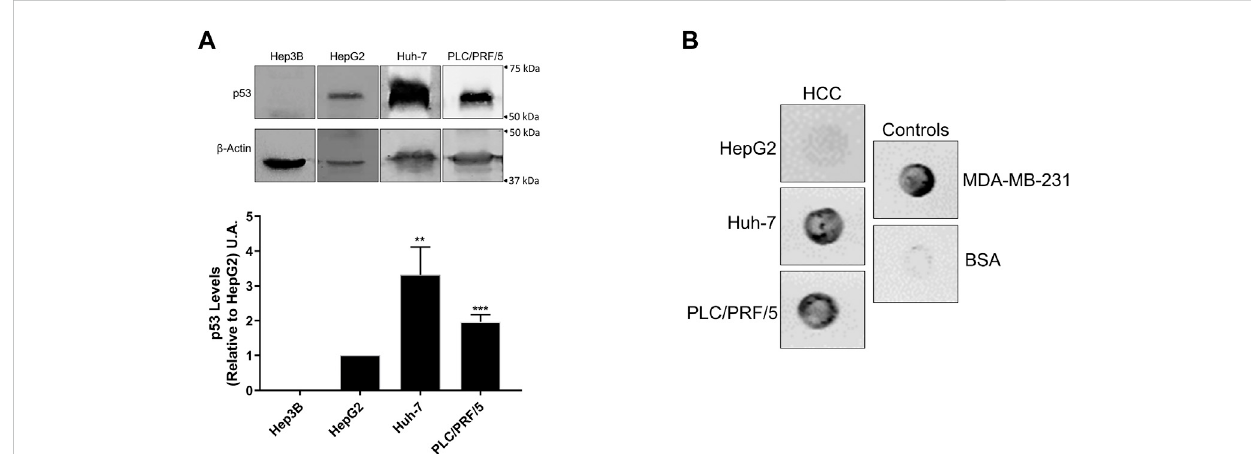
FIGURE 2 p53 and amyloid oligomer levels in hepatocellular carcinoma cell lines. (A) Western blot of HCC cell lines (upper panel) and quanti fi cation of p53 levels relative to HepG2 (lower panel). Huh-7 and PLC/PRF/5 show higher p53 levels than HepG2. The mean ± error analysis was calculated from threeindependentexperiments,where** p < 0.005and*** p < 0.001. (B) Dot-blotonnitrocellulosemembraneincubationwiththeA11antibody,showing amyloid oligomer staining for both HCC cell lines and MDA-MB-231